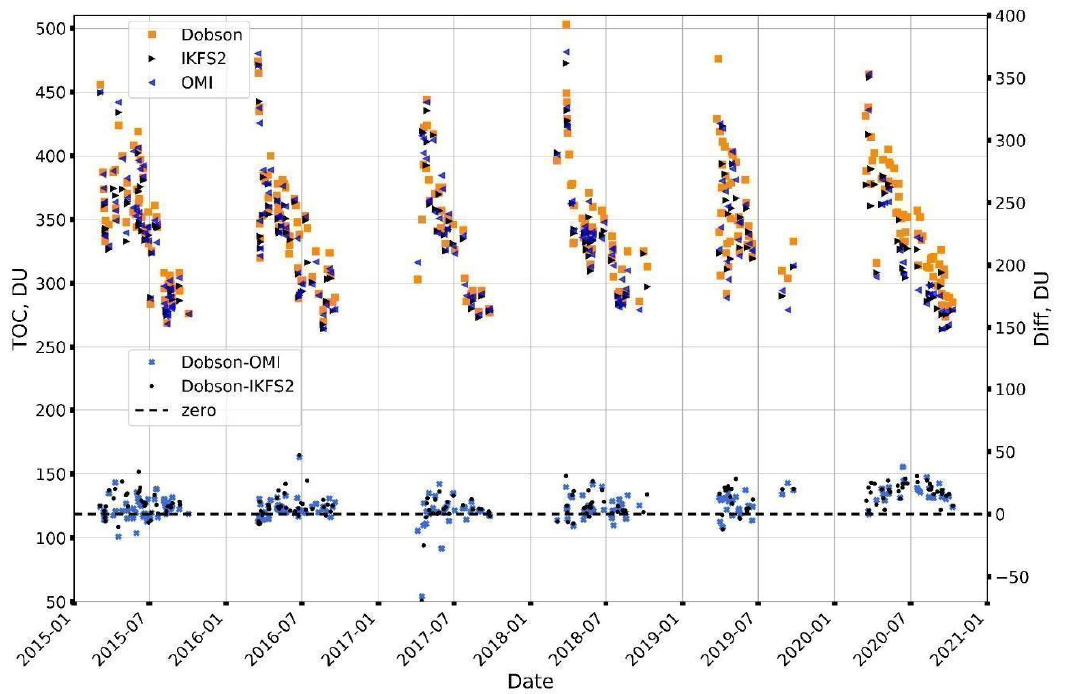
Figure 3. Time series of daily mean TOC near St. Petersburg in the 2015–2020 period according to the ground-based (Dobson) and satellite (IKFS-2, OMI) measurements (left scale) and their differences (right scale).